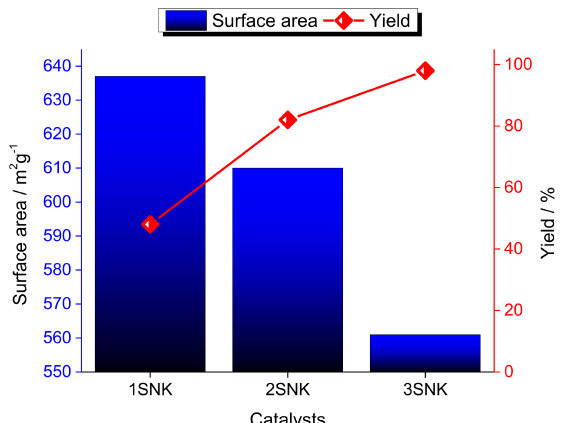
Figure 31. Yield of fatty acid methyl ester in the groundnut oil transesterification over different catalysts with methanol and the surface area of catalysts. The catalysts, in the graph, are represented by the xSNK, where x is the amount of Niobium used in the synthesis. Reaction conditions: molar ratio methanol:oil (9), catalyst (0.5 g), temperature (150 ◦ C), time (6 h) (adapted from [90]).